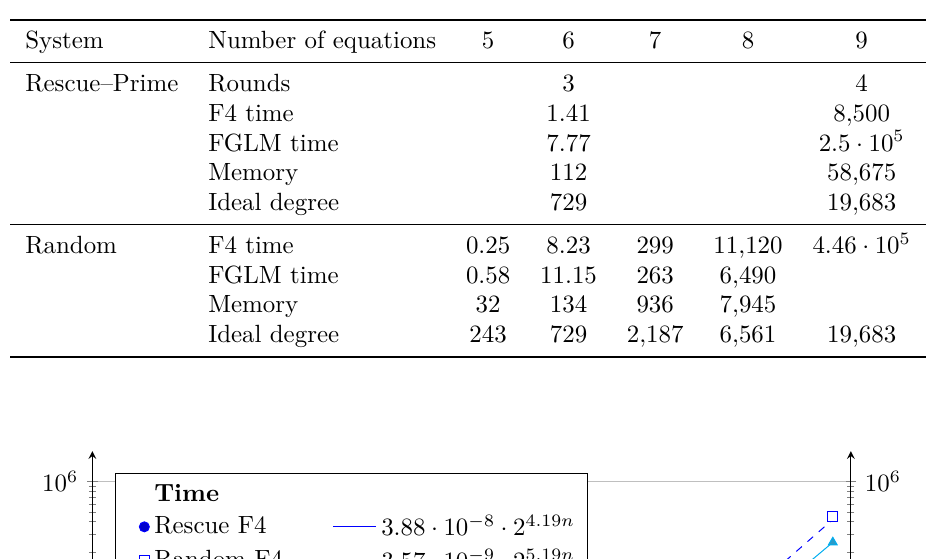
Table 5: Benchmarks of multivariate root finding with Magma using 1 CPU core of an Intel Xeon Gold 5218, for Rescue and Rescue-like systems. Times are given in seconds and memory usage in MegaBytes.